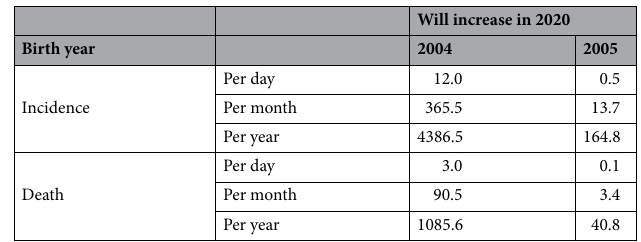
Table 1. Increased future incidence and death for each birth FY. The increased numbers of future incidence and death in each birth FY, compared to those of females born in FY1999 (most of whom received HPV vaccination with public subsidies before the suspension of the recommendation in FY2013) were calculated. The risk for females born in and after FY2006 could not be calculated because the vaccination rates were available only for those born in and before